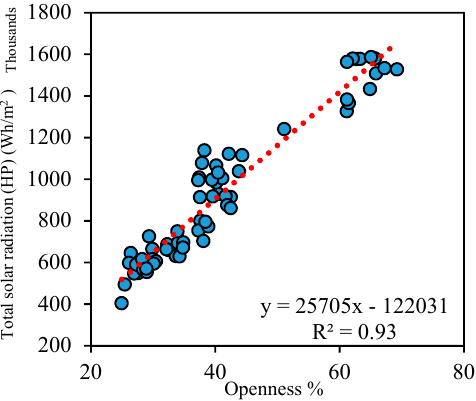
Figure 10. The correlation between the openness and potential total (direct + diffuse) solar radiation derived from HP in W·h/m 2 for an entire growing season (64 plots).